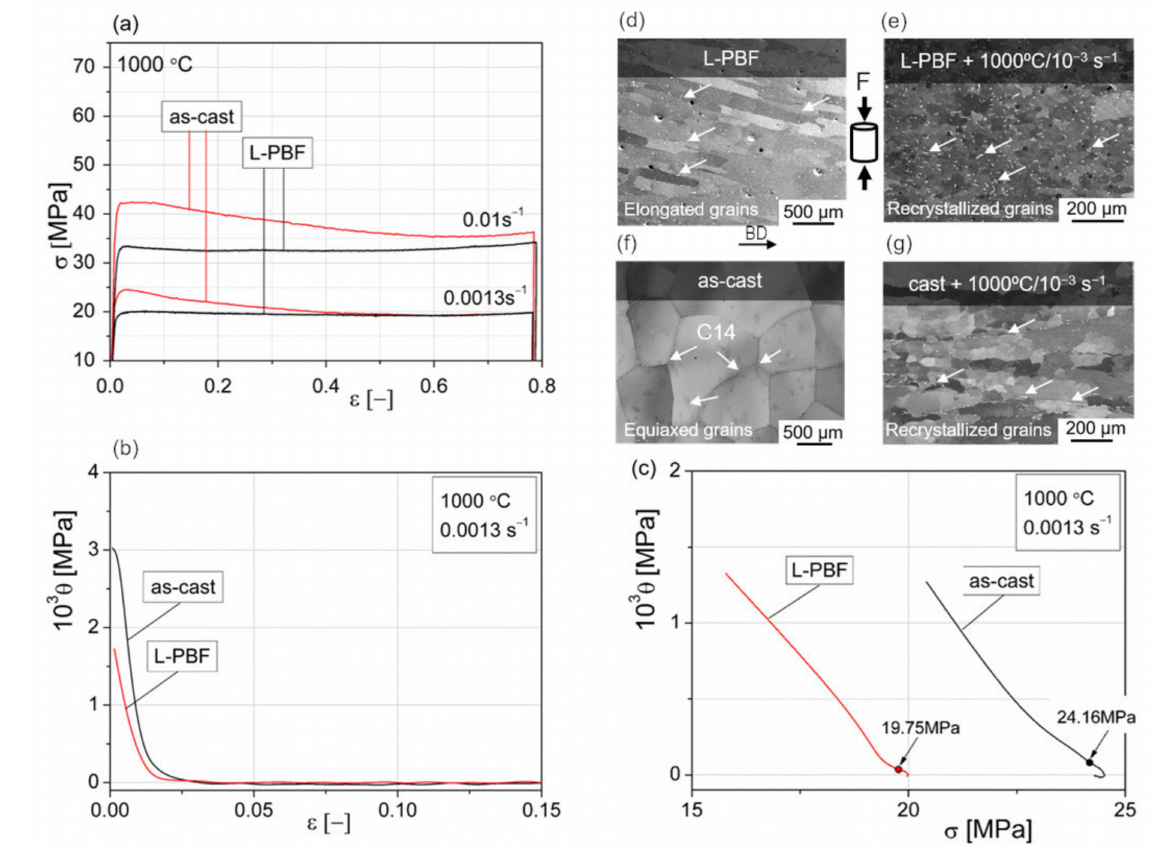
Figure 5. True stress–strain curves of L-PBF and the as-cast materials hot compressed at 1000 ◦ C to a true strain of 0.8 at different strain rates ( a ), θ – ε curves ( b ), θ – σ curves ( c ), and initial and post- deformation microstructures of the L-PBF and as-cast specimens deformed at 1000 ◦ C/0.0013 s − 1 to a true strain of 0.8 ( d – g ). The loading direction, F, is normal to the BD in L-PBF builds. The points in ( c ) denote the critical stress values for DRX initiation. The arrows refer to a few C14–Laves phase precipitates that resided at the GBs and the grain interiors. The data for the as-cast material were taken from